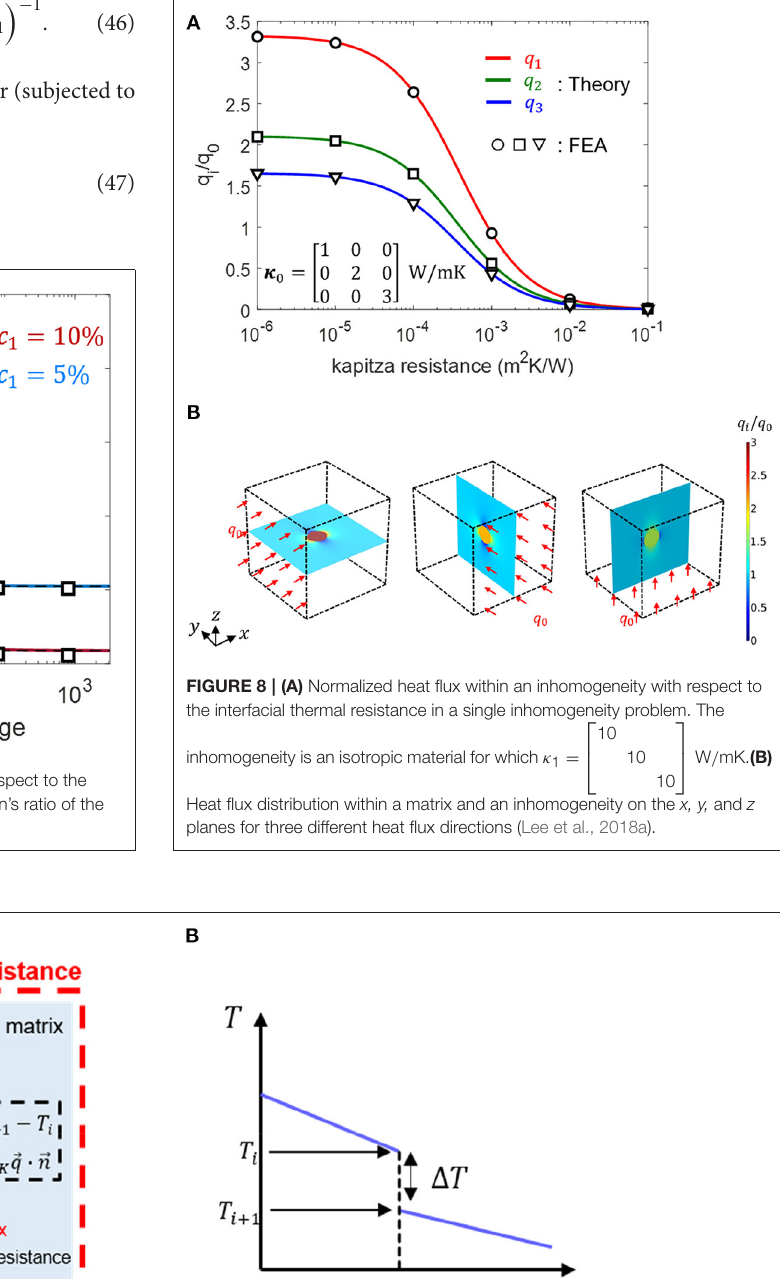
Frontiers in Materials |